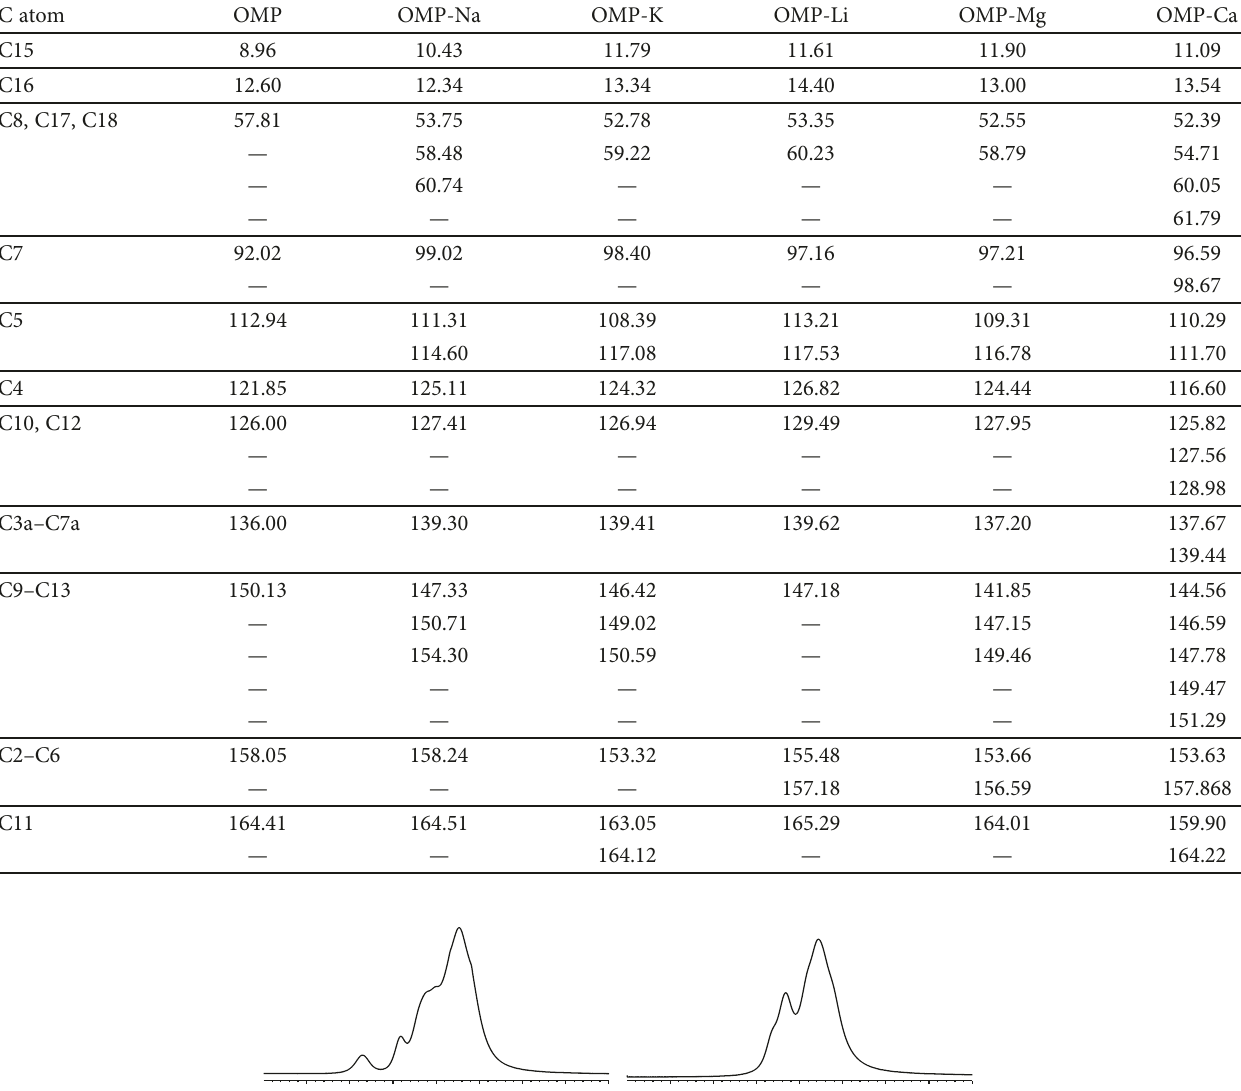
Table 1: Carbon chemical shifts (ppm) of OMP and its salts.